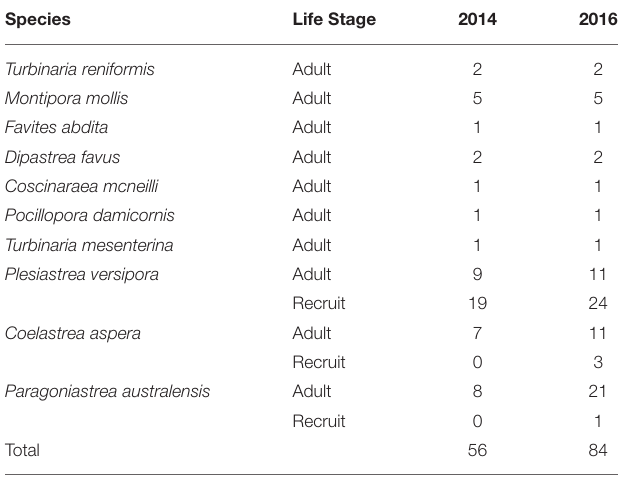
TABLE 1 | Relative abundances of species at different life stages before (2014) and after (2016) the Marine Cold Spell in permanent plots within Marmion Marine Park.